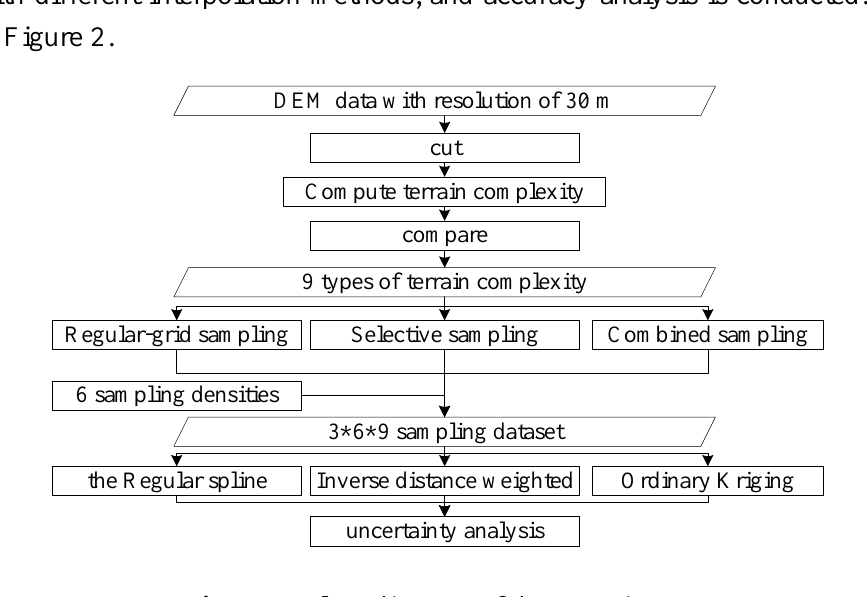
Figure 2. Flow diagram of the